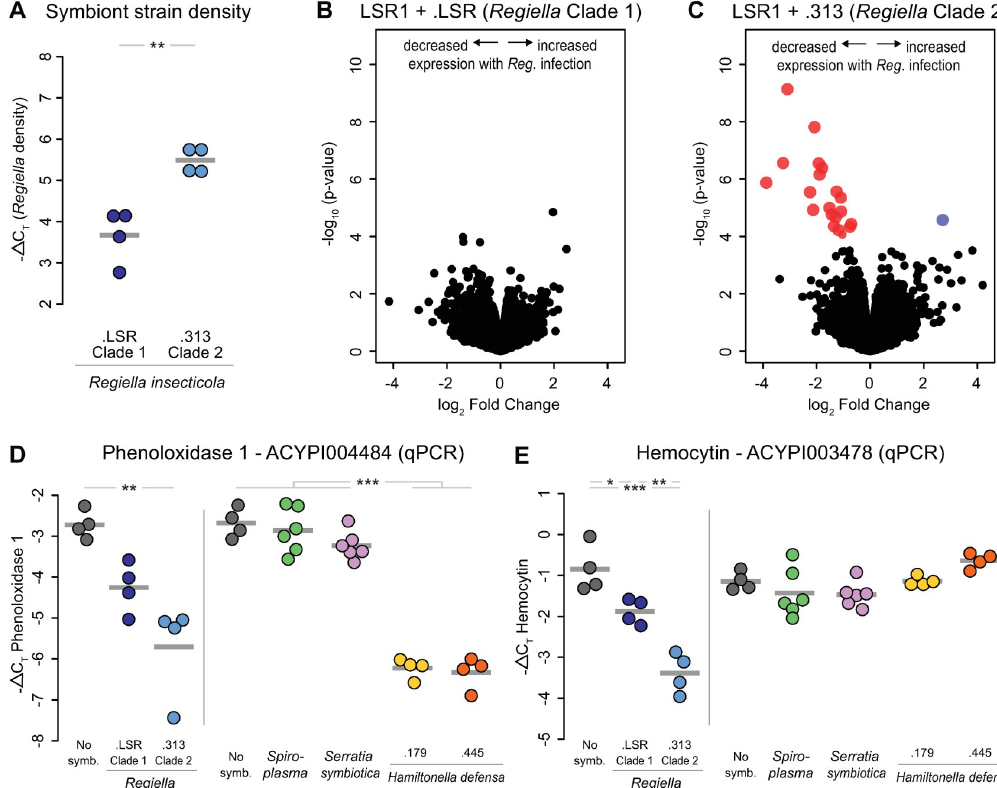
Fig 1. Effects of hosting facultative symbionts on aphid gene expression. A: Density of lines harboring a Clade 1 (.LSR) and a Clade 2 (.313) strain of Regiella . The y-axis shows the - Δ C T values which can be interpreted on a log 2 scale. The average - Δ C T value for each Regiella strain is shown with a grey bar. Statistical significance (t-test) is shown along the top of the figure. B&C: Volcano plots of RNAseq data comparing expression of each expressed gene in the aphid genome, represented by a point in each figure, between aphids with and without Regiella . B and C show this analysis for aphids with a Regiella strain from Clade 1 and Clade 2, respectively. The x-axes show the log 2 fold change for each gene, and the y-axis shows the significance of expression. Blue and red dots represent genes that were significantly up- or down-regulated, respectively, at an FDR < 0.05. D: qPCR analysis of gene expression of phenoloxidase 1 ( PO1 ; ACYPI004484) in response to different species of facultative symbionts. The grey dots represent aphids without facultative symbionts, and the colored dots show those with symbiont infections 4 generations after symbiont establishment. The average - Δ C T value for each group is shown with a grey bar. The different symbiont species and strains are shown along the bottom of the figure. The y-axis shows the - Δ C T values of expression, which can be interpreted on a log 2 scale. Statistical significance among species or strains (ANOVA & Tukey’s HSD post-hoc analysis) is shown along the top of the figure; the two experiments, which are separated by a vertical line, were analyzed separately. E: Same as panel D but for the gene hemocytin (ACYPI003478).